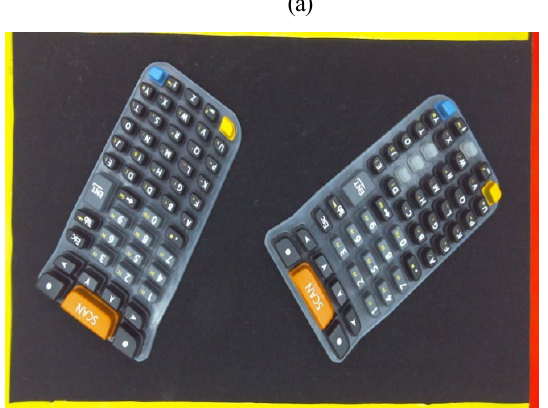
Figure 12. (a) Four input keypads; (b) Three input keypads; (c) Resulting image of (a) after applying mode 1 algorithm; (d) Resulting image of (c) after applying mode 1